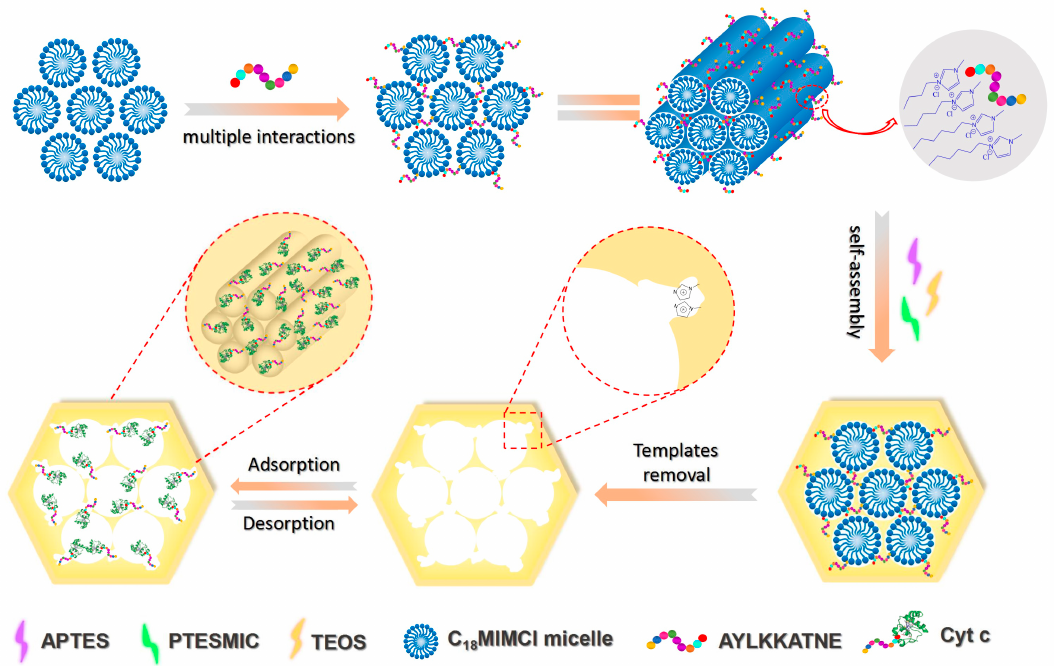
Scheme 1. Schematic illustration of the synthesis procedure of MIMs and the selective process for the enrichment of Cytochrome c (Cyt c) using MIMs.